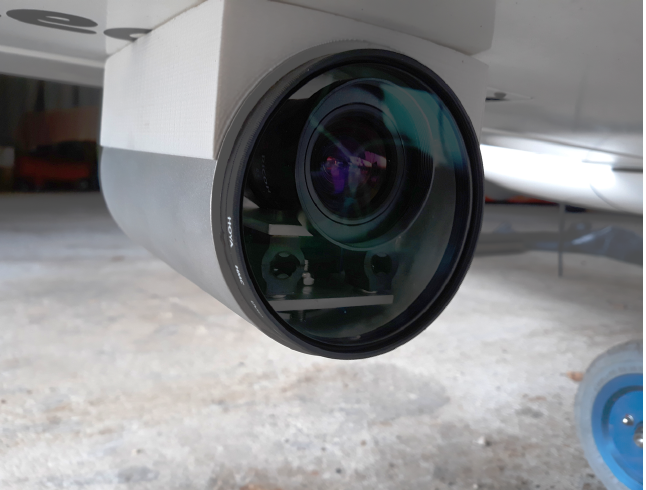
Figure 9. Camera under the wing of K50 aircraft. Metallic tube and replaceable filter provide physical defense while vibration dumpers reduce blur effects caused by high-frequency